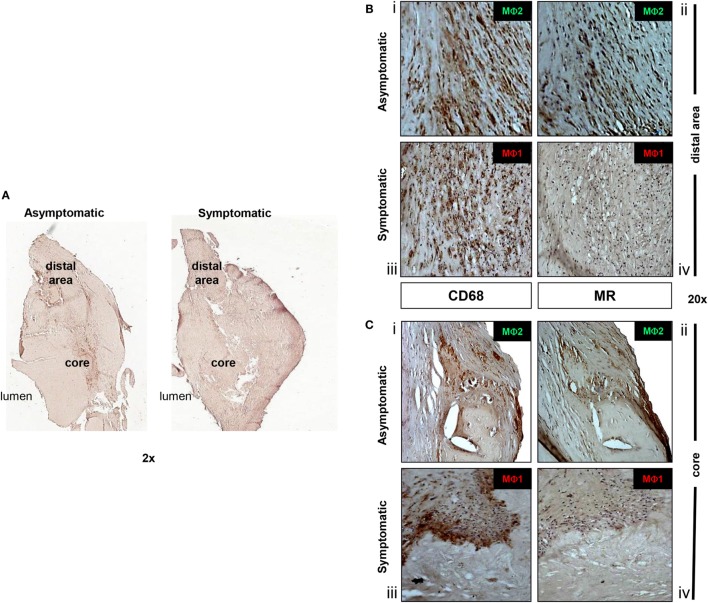
Anti-inflammatory MΦ2 macrophages are decreased in symptomatic plaques. (A) In both asymptomatic and symptomatic lesions, a central area, corresponding to the lesion initiation site (core) and a peripheral region (distal area) of the plaque were identified. In the “distal area” of asymptomatic patients, MΦ2 (CD68+/MR+) are predominant (B) (i,ii). Although still present in peripheral areas, MΦ2 populations are also located in the developing core of the asymptomatic plaques (C) (i,ii). Conversely, symptomatic lesions are characterized by the predominance of MΦ1 macrophages (CD68+/MR-), in both the distal and developed core (B) (iii,iv) and (C) (iii,iv). Pictures were captured using TLM (2 and 20× magnifications). Representative images of N = 3 independent staining are shown.